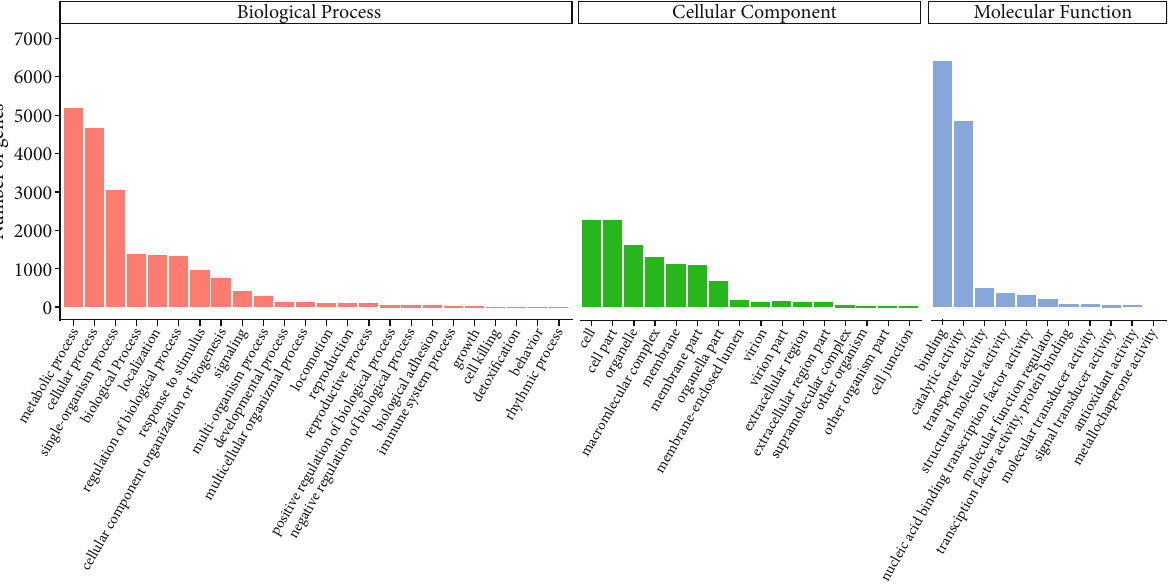
Figure 7: GO classi fi cation of tiger lily transcripts. BP, CC, and MFs are indicated by red, green, and blue colors, accordingly.